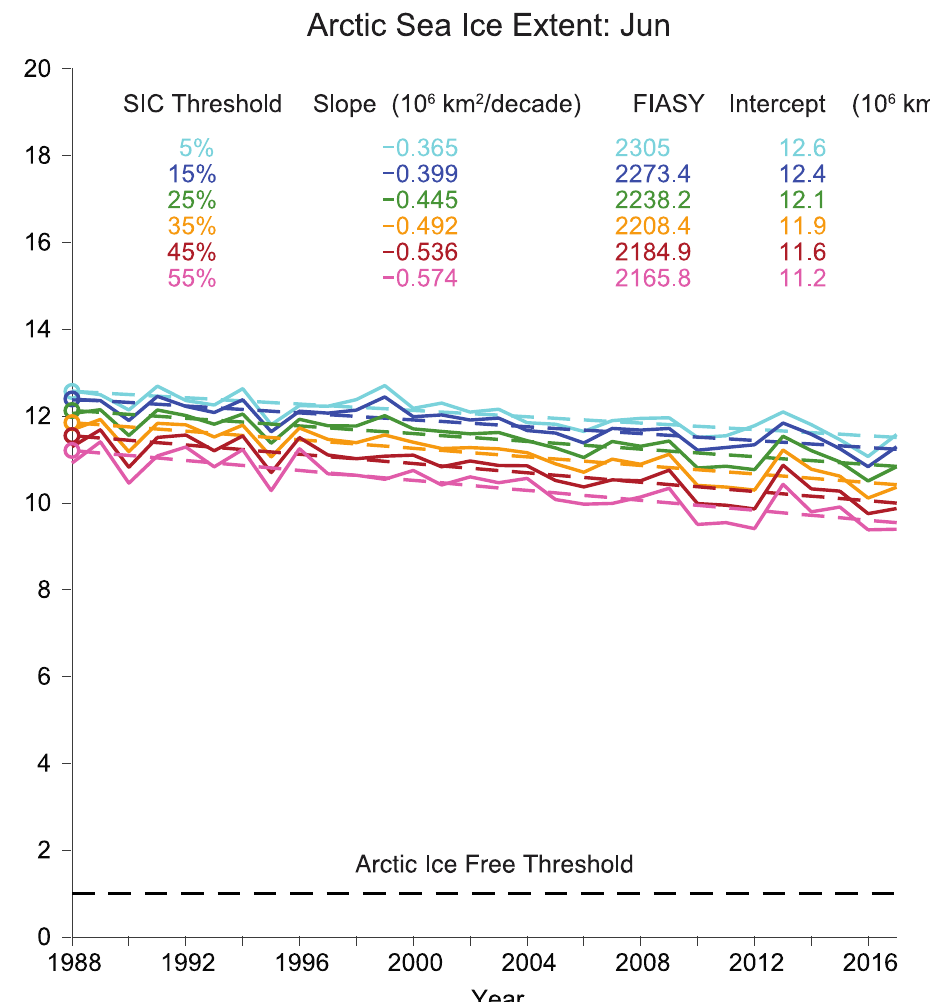
Figure 8. Arctic June monthly SIE time series (solid) for 1988–2017 and their linear regressions (dashed) for varying SIC thresholds.